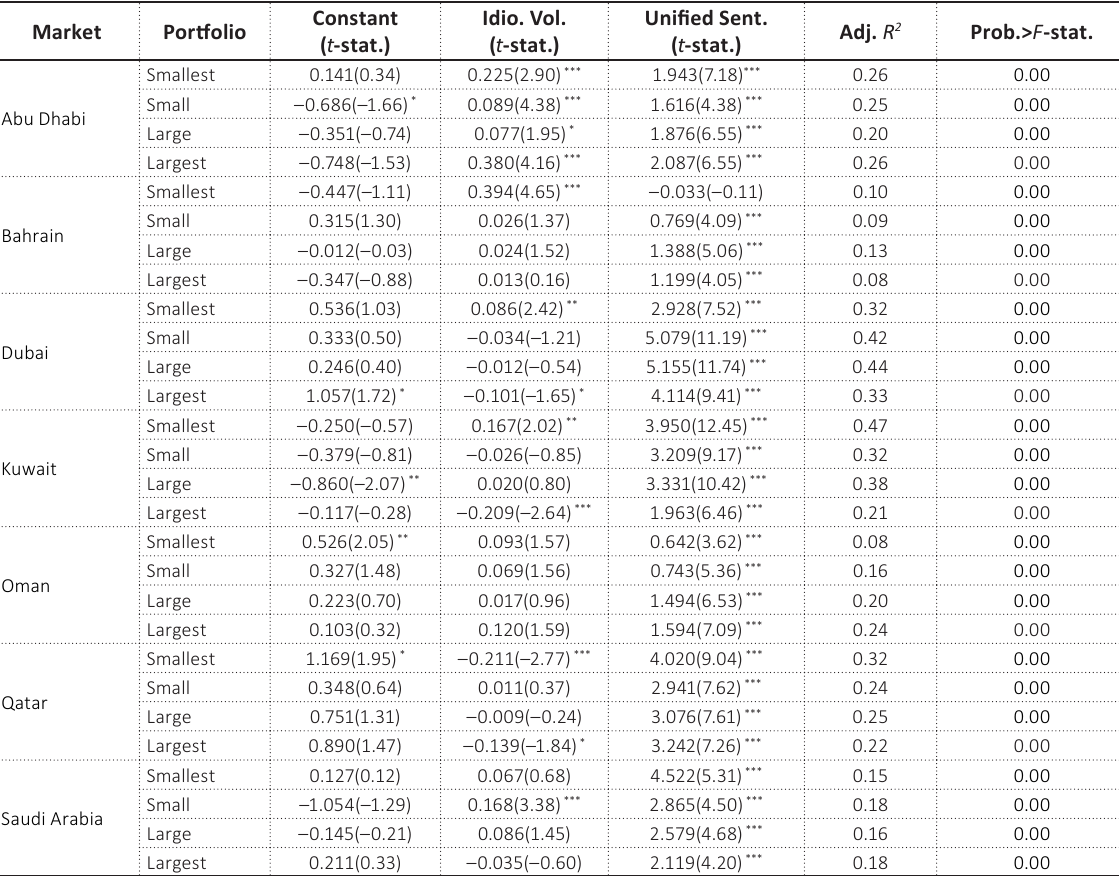
Table 4. Impact of idiosyncratic volatility and sentiment on size-portfolio returns